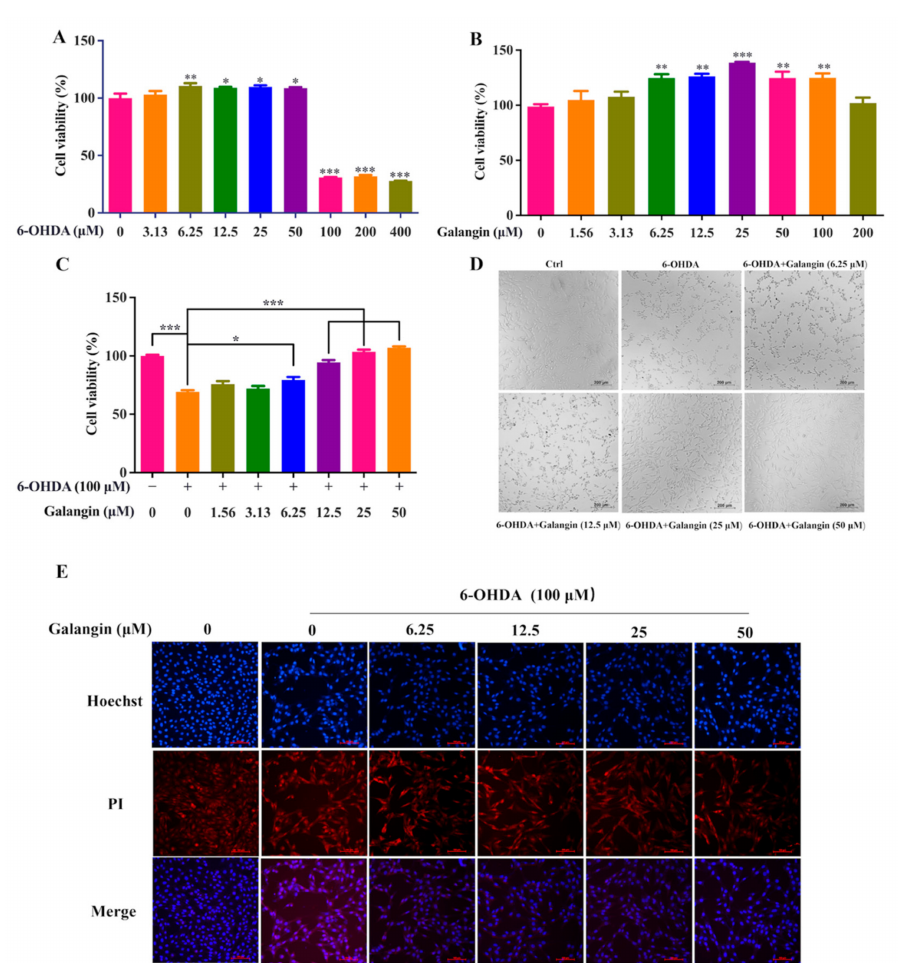
Figure 4. Galangin decreased cell death in 6-OHDA-treated HT22 cells. ( A ) MTT assay of the viability of HT22 cells treated with 3.13–400 µ M 6-OHDA for 24 h. ( B ) MTT assay of the viability of HT22 cells treated with 1.56–200 µ M galangin for 24 h. ( C ) MTT assay of the viability of HT22 cells treated with 1.56–50 µ M galangin in the absence or presence of 6-OHDA for 24 h. ( D ) Representative images of the cell morphology of HT22 cells treated with 6.25–50 µ M galangin in the absence or presence of 6-OHDA for 24 h. Magnification: 10 × ; Scale bars: 200 µ m. ( E ) Representative Hoechst/PI staining images of HT22 cells treated with 6.25–50 µ M galangin in the absence or presence of 6-OHDA. Magnification: 10 × ; Scale bars: 100 µ m. Bars, S.D., * p ≤ 0.05, ** p ≤ 0.01, *** p ≤